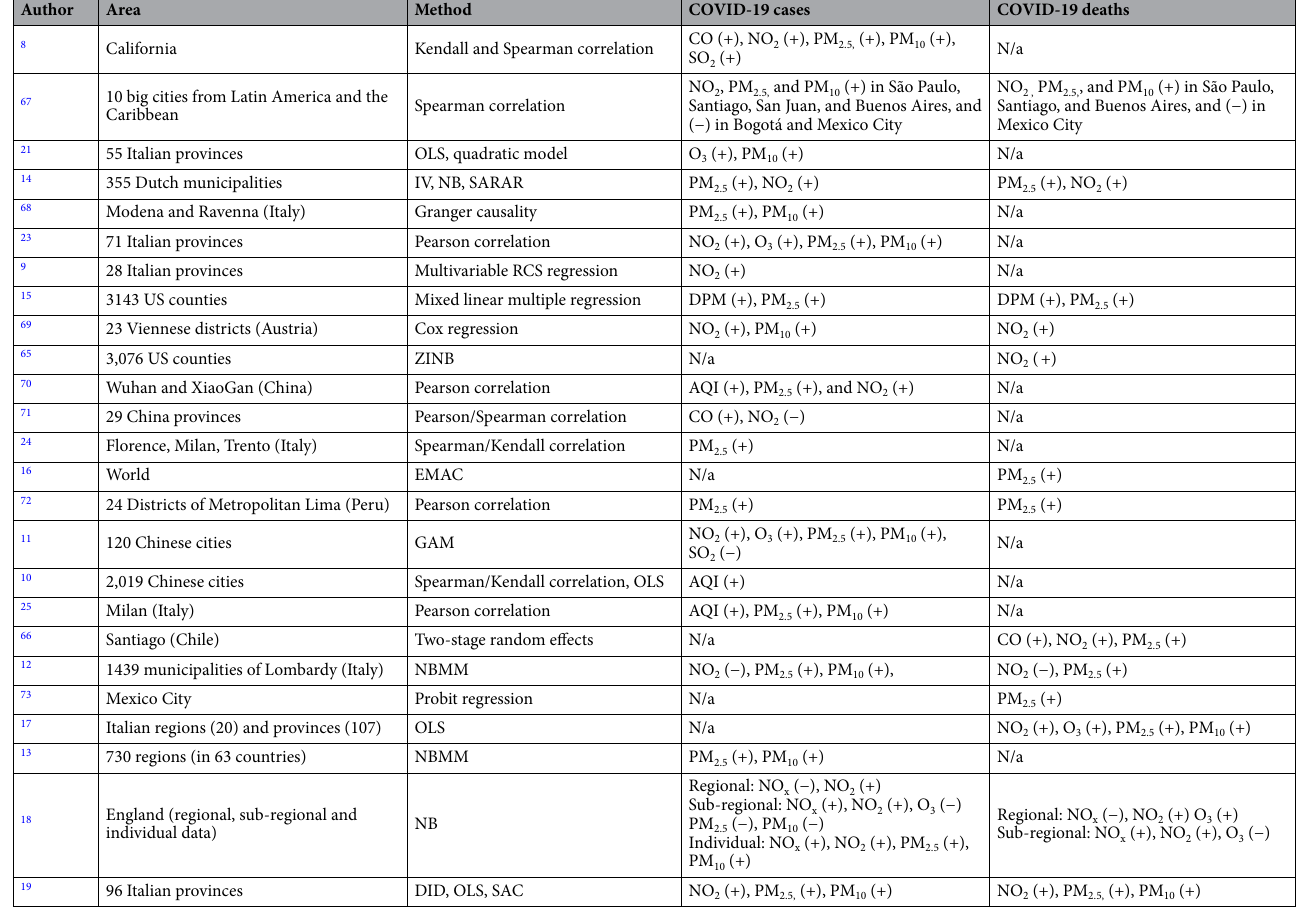
Table 5. 25 Selected studies on the relationship between exposure to air pollution and COVID-19 spread and related mortality across the world. AIQ air quality index, DID difference-in-difference, EMAC